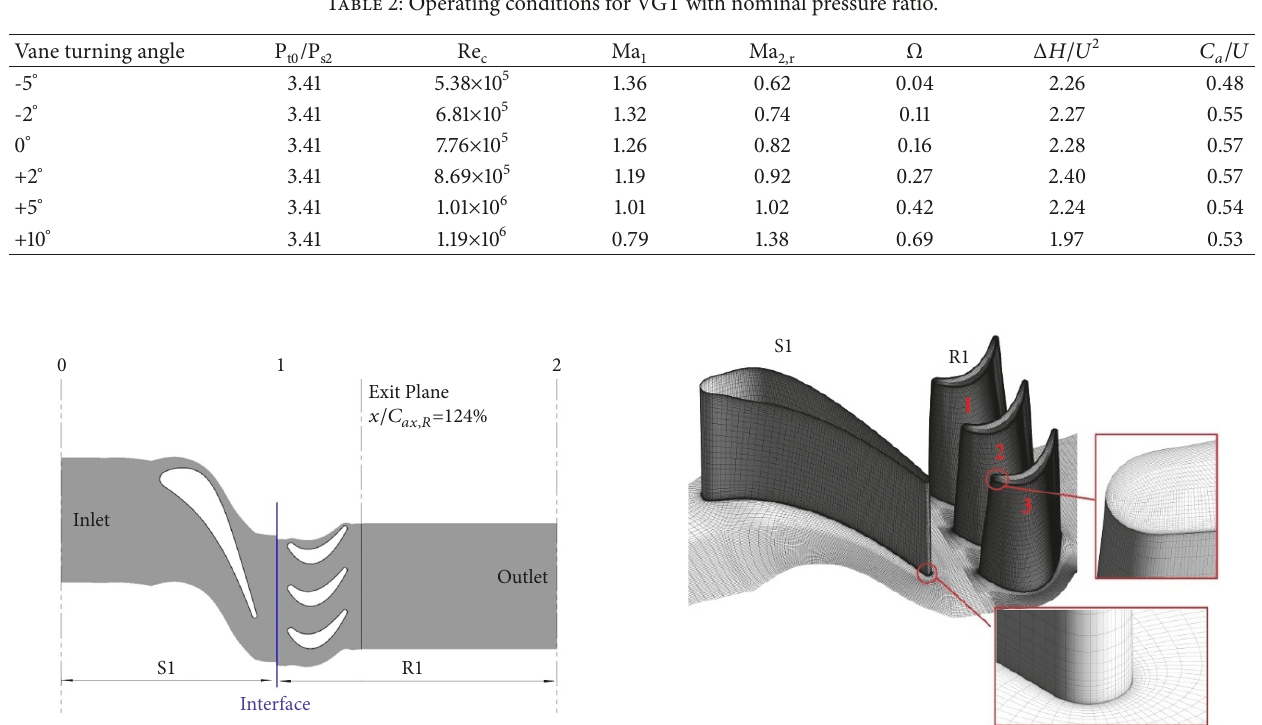
Figure 2: The computational domain in this study. Figure 3: Computation grid in this study.